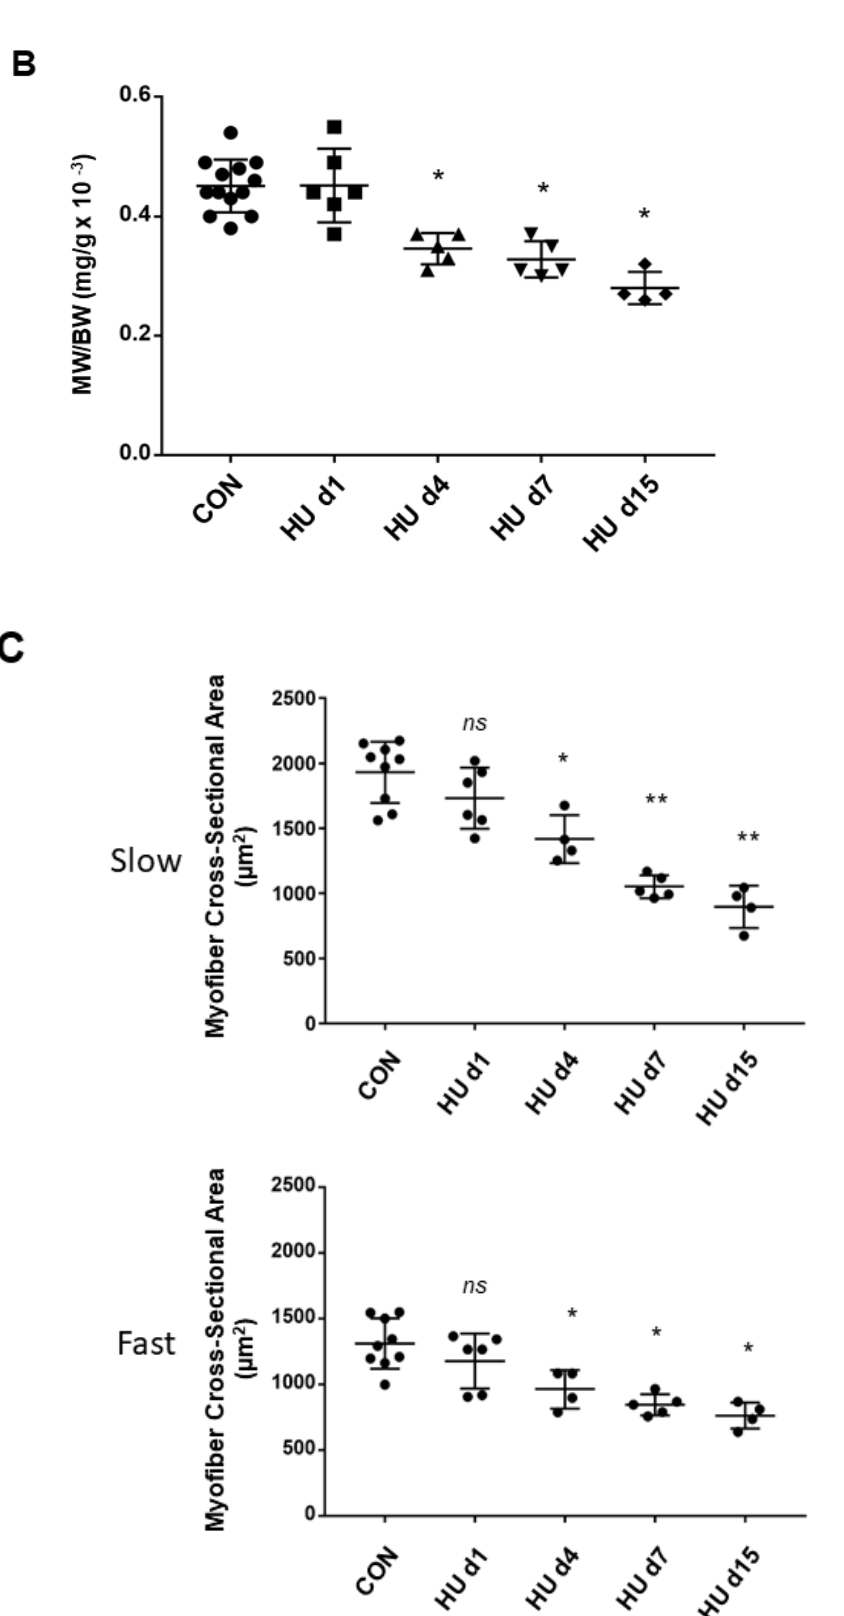
Figure 4. Time course of Homer 1a, 1b/c, and 2 isoform expression and morphometry analysis in rat SOL muscle. ( A ) Real-time qPCR analysis of ambulant CON vs. HU. A decrease in all Homer isoform transcripts was observed after 1 day of HU, which continued to decrease after 2 weeks: Homer1a −